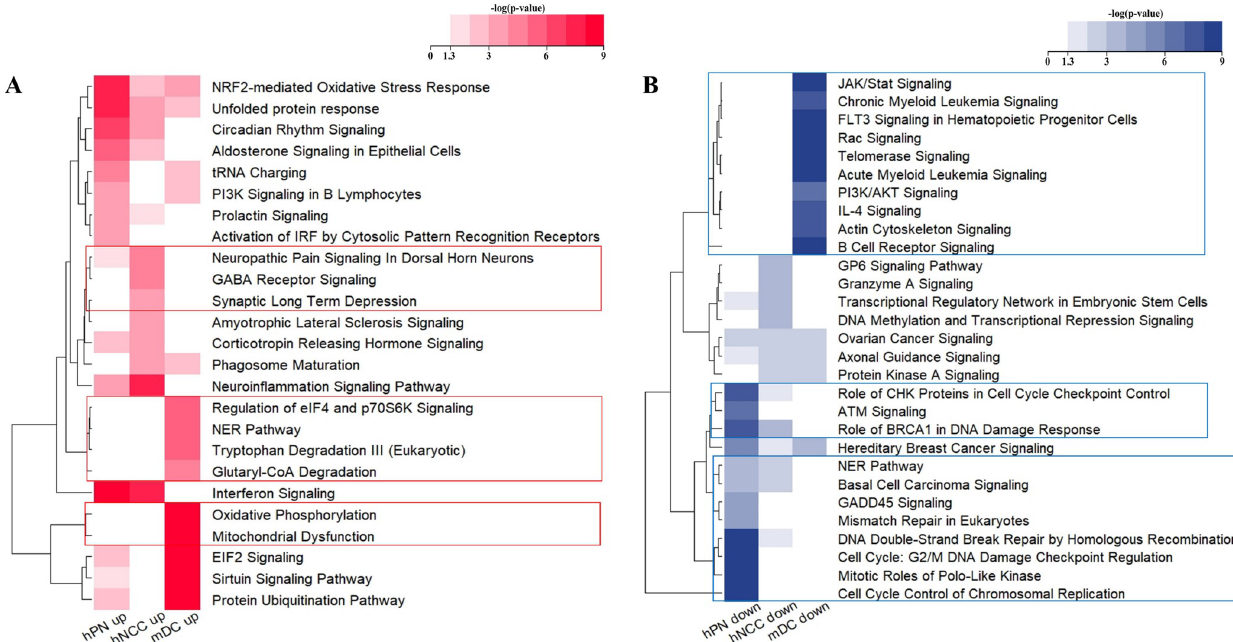
Fig 2. Heat maps for comparative analysis of significant biological pathways in ZIKV-infected cells. Heat maps were generated using Fisher’s exact tests ( p value) for pathways from gene set enrichment analysis. The values were converted to–log 10 ( p value), indicating the significance of the biological pathways containing DEGs. A value of 1.3 indicates a p value of 0.05. Additionally, the boxed line shows the specifically altered pathways in macrophages. (A) Heat map showing upregulated biological pathways. (B) Heat map showing significantly downregulated biological pathways. The heat maps were generated using R